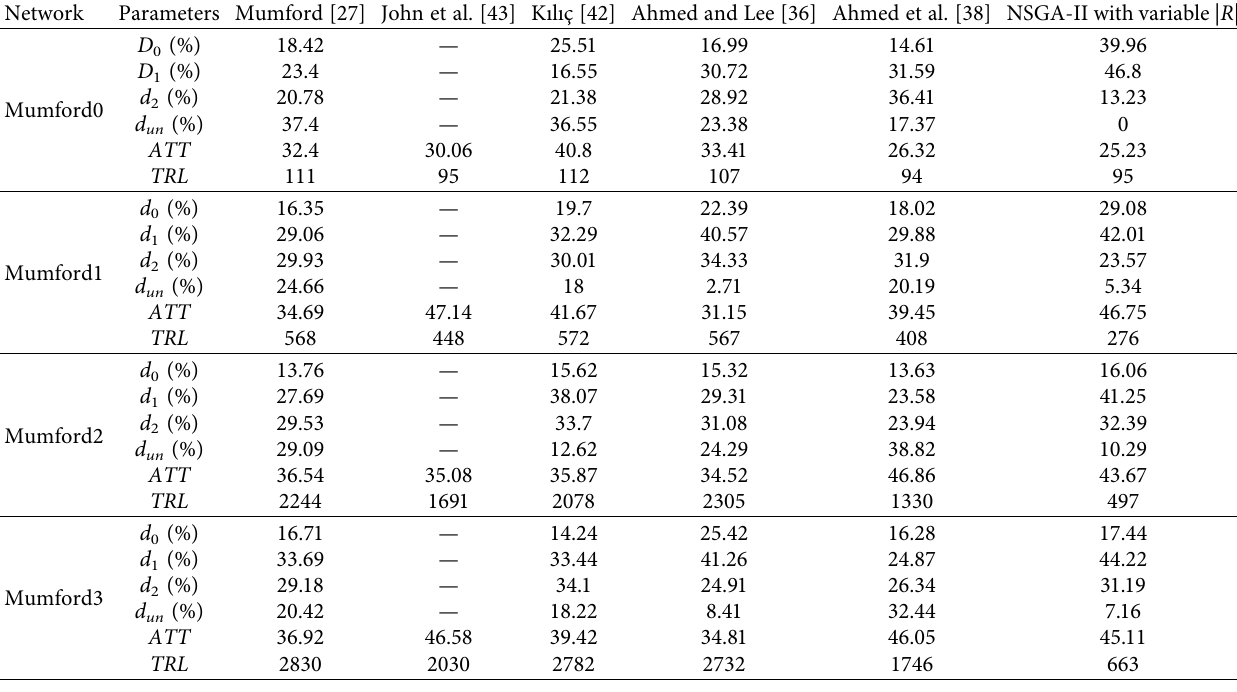
Table 11: Operator perspective results compared to other approaches for Mumford’s networks. Network